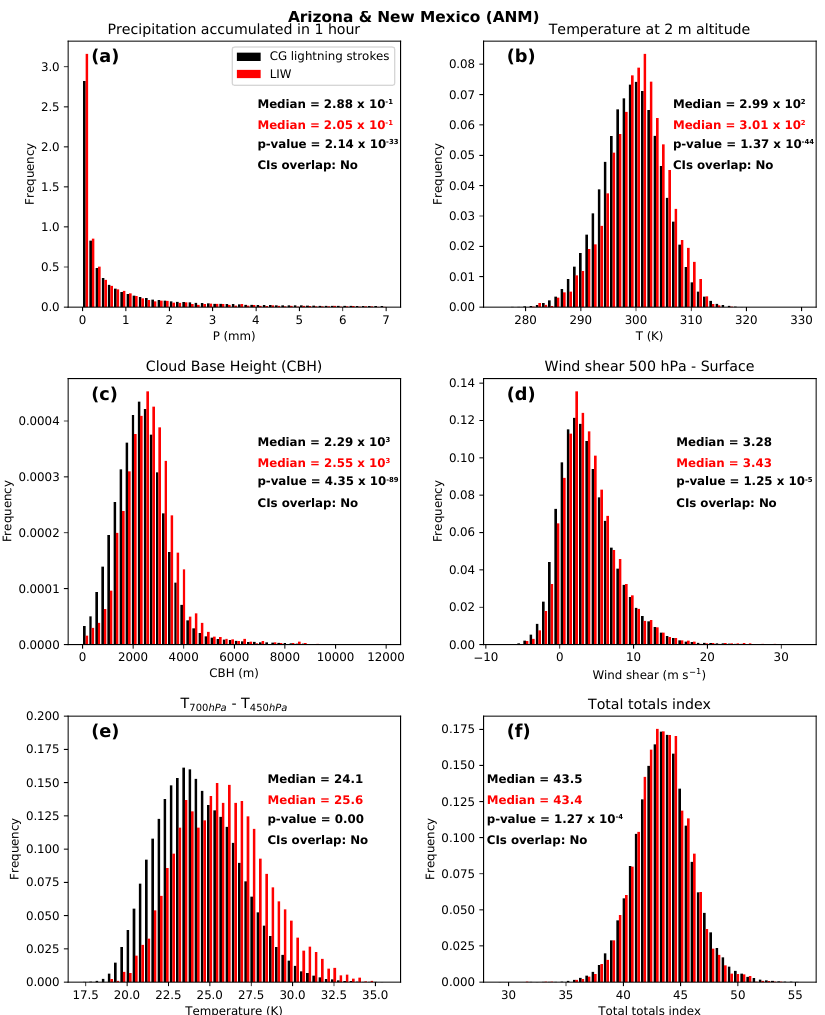
Figure 4. Frequency distribution of hourly accumulated precipitation ( a ), air temperature at 2 m altitude ( b ), CBH value ( c ), wind shear between the pressure level of 500 hPa and the surface ( d ), temperature difference between the 700 hPa and 450 hPa pressure levels ( e ), and Total Totals Index ( f ) for CG lightning strokes (black) and LIW (red) over ponderosa and pinyon-juniper woodland forests in Arizona and New Mexico during the fire season between 2009 and 2013. The p -values were obtained from the Kruskal–Wallis H-tests [59]. The analysis results for the overlap of the 95% bootstrap CI of the medians are